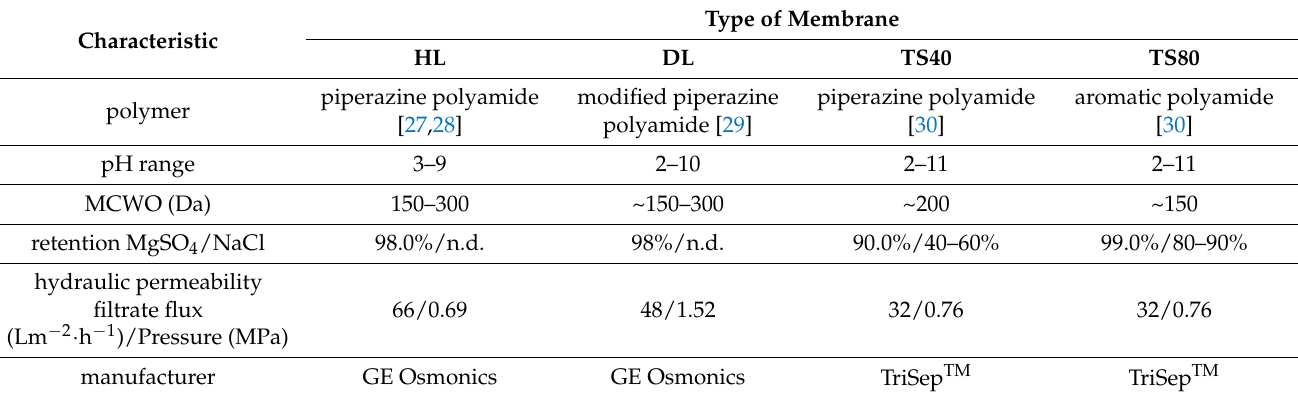
Table 2. Parameters of membranes used in the